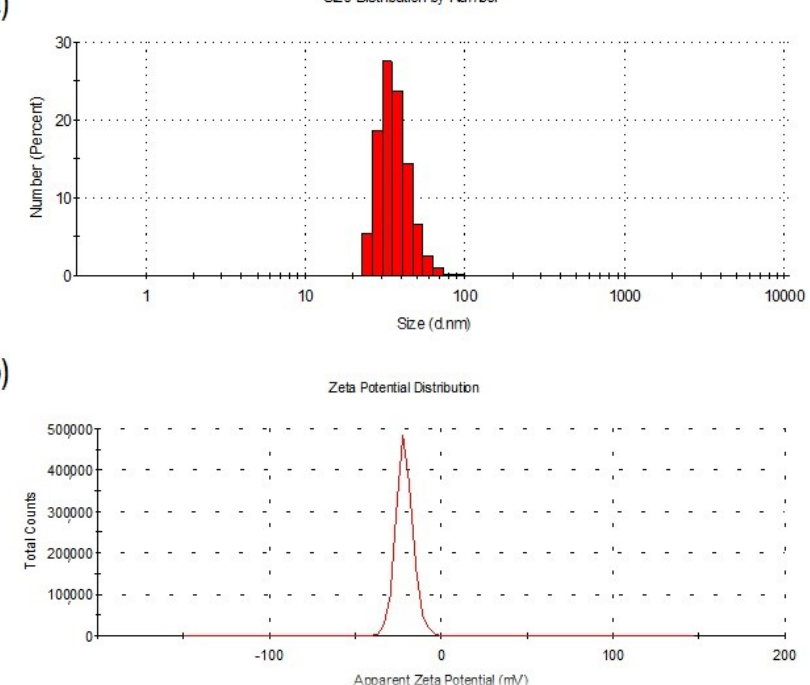
Figure 1. Characterization of the AgLeNPs. ( a ) particle size distribution determined by DLS. ( b ) Zeta potential distribution determined by DLS.